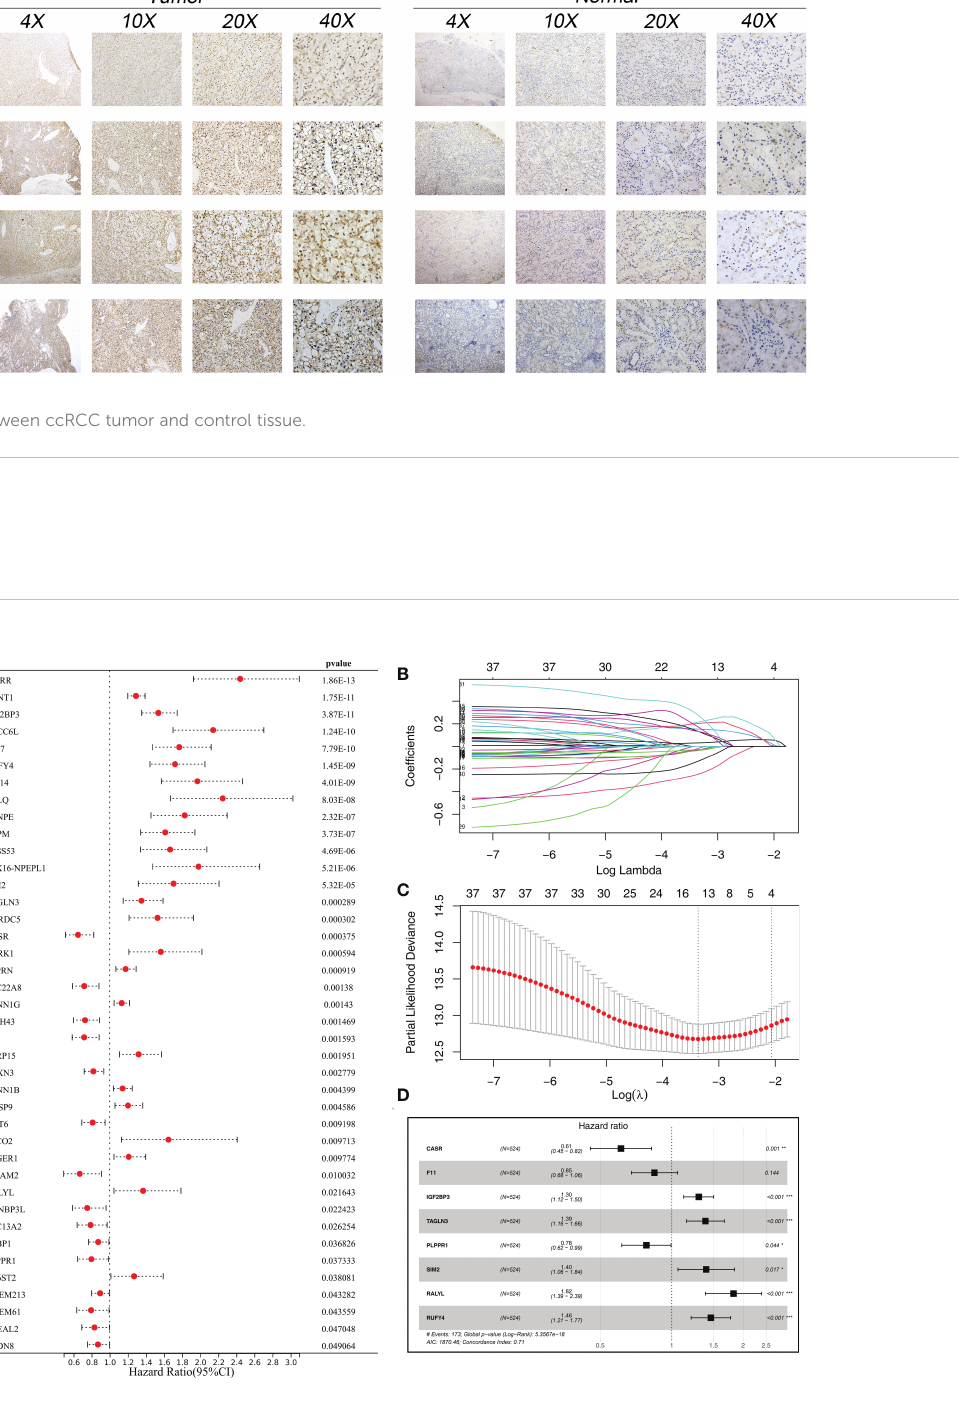
FIGURE 8 Identi fi cation of the prognosis signature based on the machine learning algorithm from MYBL1-derived molecules. (A) The top 50 molecules signi fi cantly correlated with patients prognosis from MYBL1-derived molecules; (B, C) LASSO logistics regression was utilized for data dimension reduction; (D) Multivariate cox regression analysis.